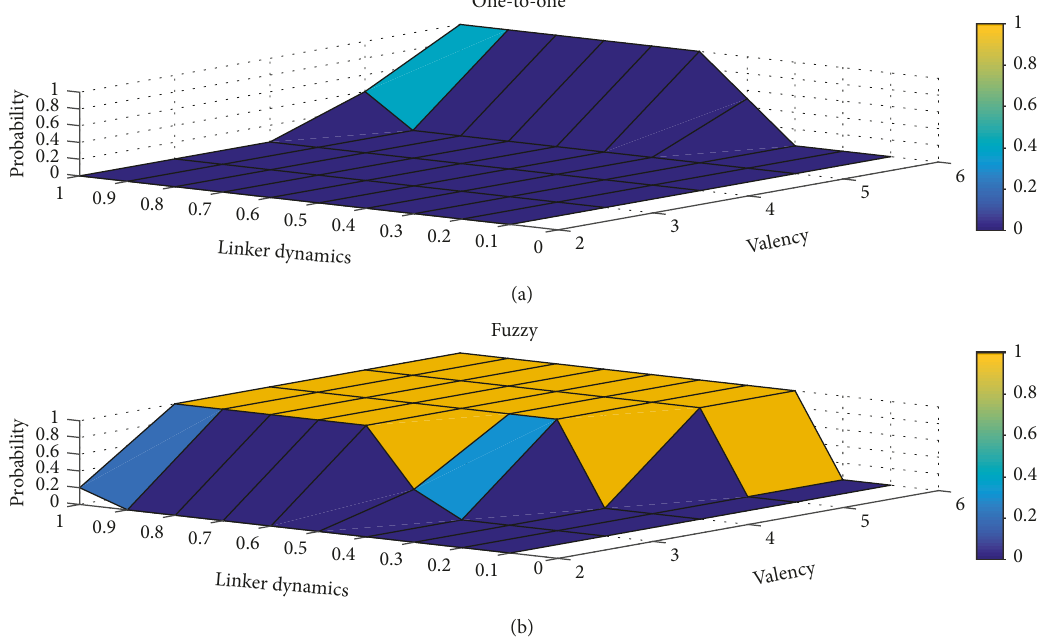
Figure 6: Probability of large polymers as a function of valency and linker dynamics in the one-to-one (a) fuzzy (b) binding models. Linker dynamics is computed as the average of the residue-based values (equation (5).). Binding element a ffi nity =0.35; box